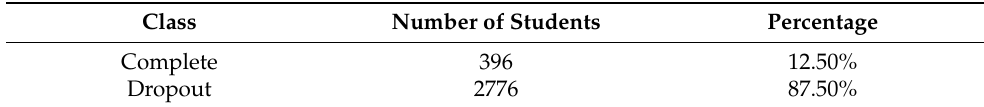
Table 1. Distribution of Students in the